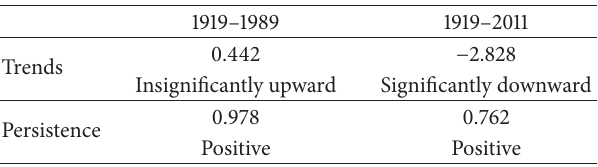
Table 3: Results of runoff trend and persistence tests of 1919–1989 and 1990–2011 (throughout the study period).